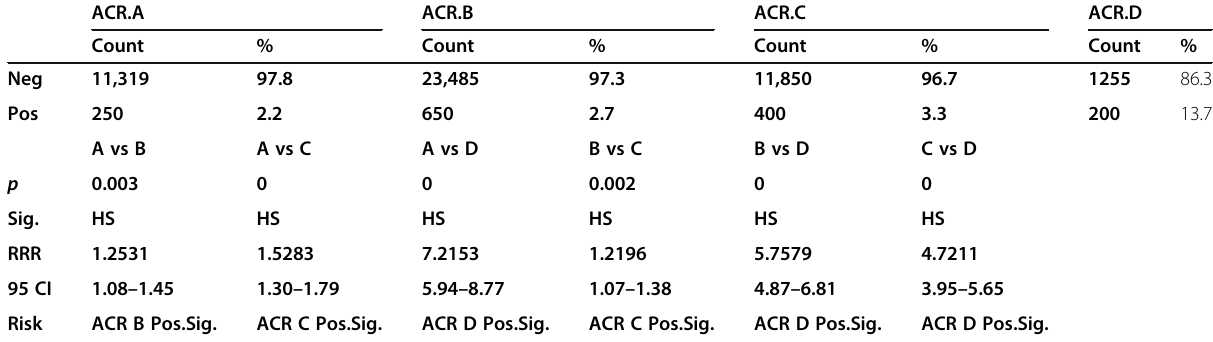
Table 1 Breast density and increased breast cancer